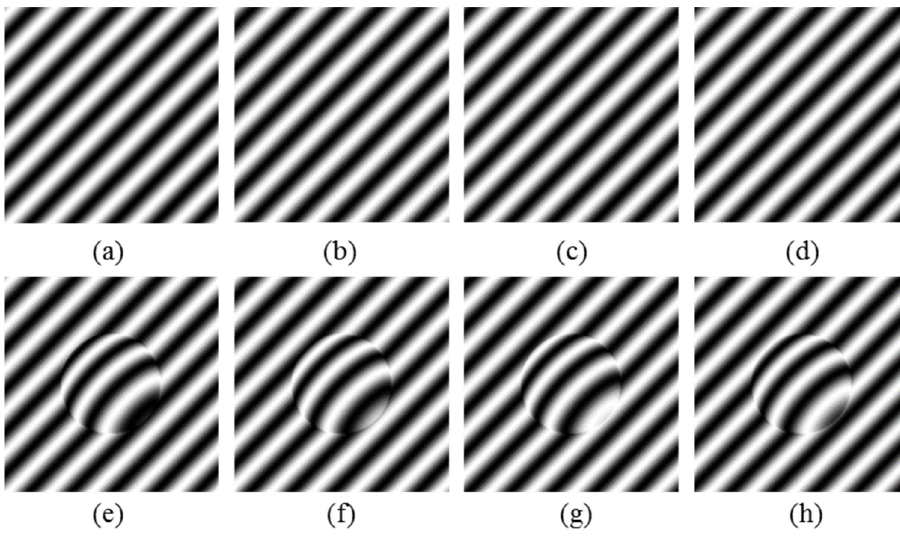
Figure 4. ( a – d ) The four fringe images; ( e – h ) the four deformed fringe images.